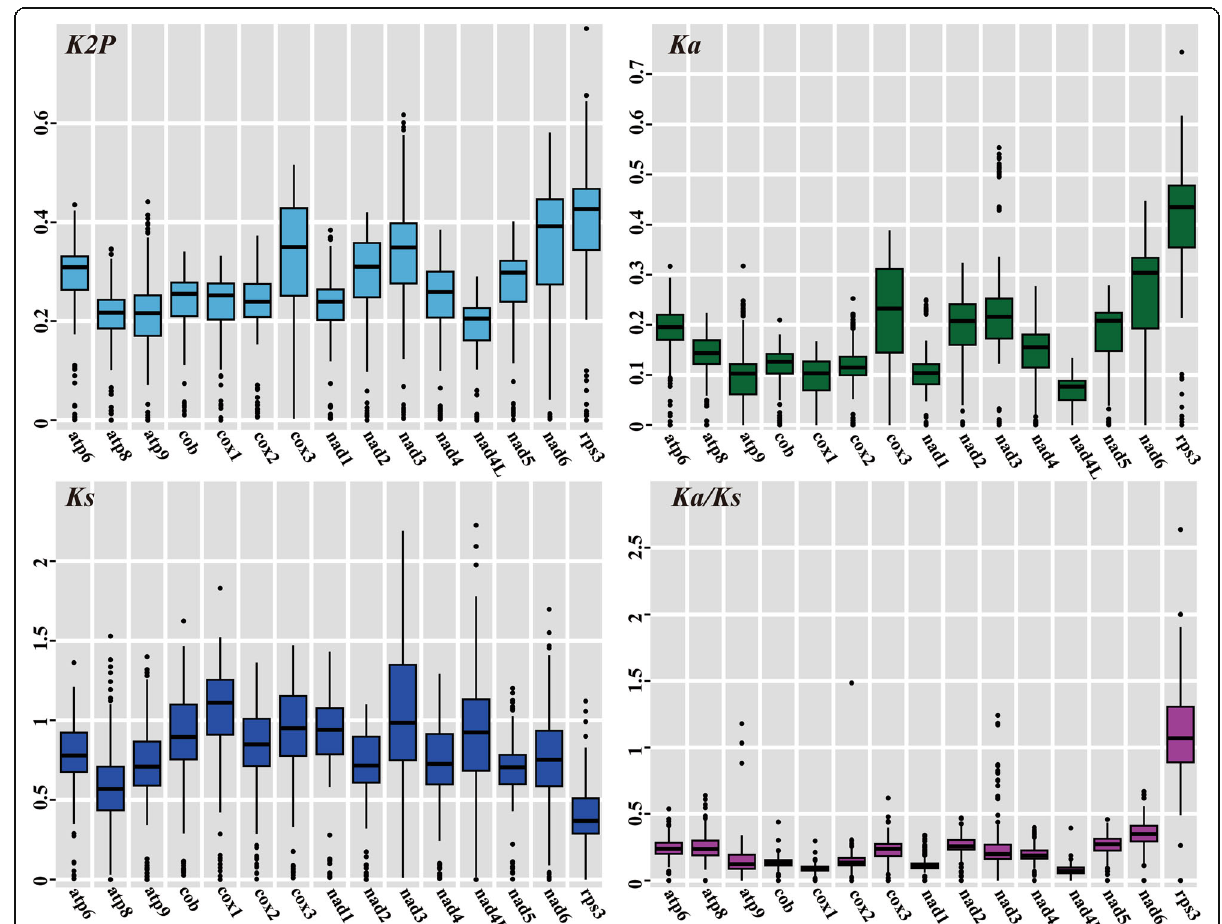
Fig. 4 Genetic analysis of 15 core protein coding genes conserved in the 22 Agaricales mitogenomes. K2P, pairwise genetic distances between each pair of the 15 core PCGs in the 22 Agaricales mitogenomes based on the Kimura-2-parameter model; Ka , nonsynonymous substitution site; Ks , synonymous substitution site. Species and NCBI accession number used for gene arrangement analysis in the present study are listed in Supplementary Table